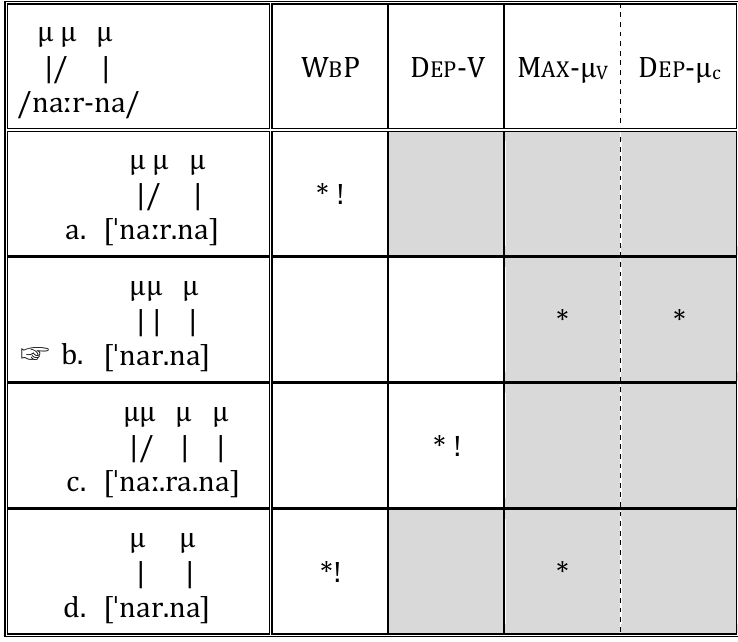
Tableau 4 : A vocalic mora is deleted to avoid a violation of W B P and D EP